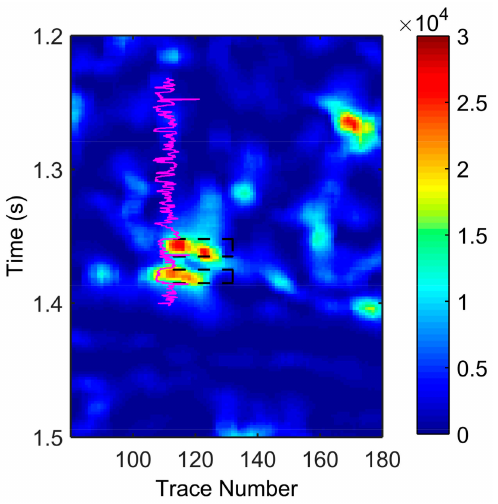
Figure 13. The details of Figure 12a near hydrocarbon